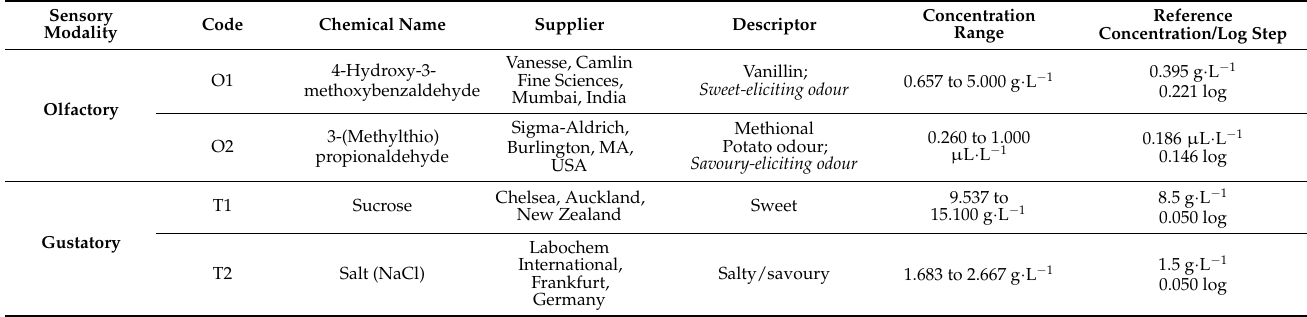
Table 1. Summary of the characteristics of the stimuli used in the